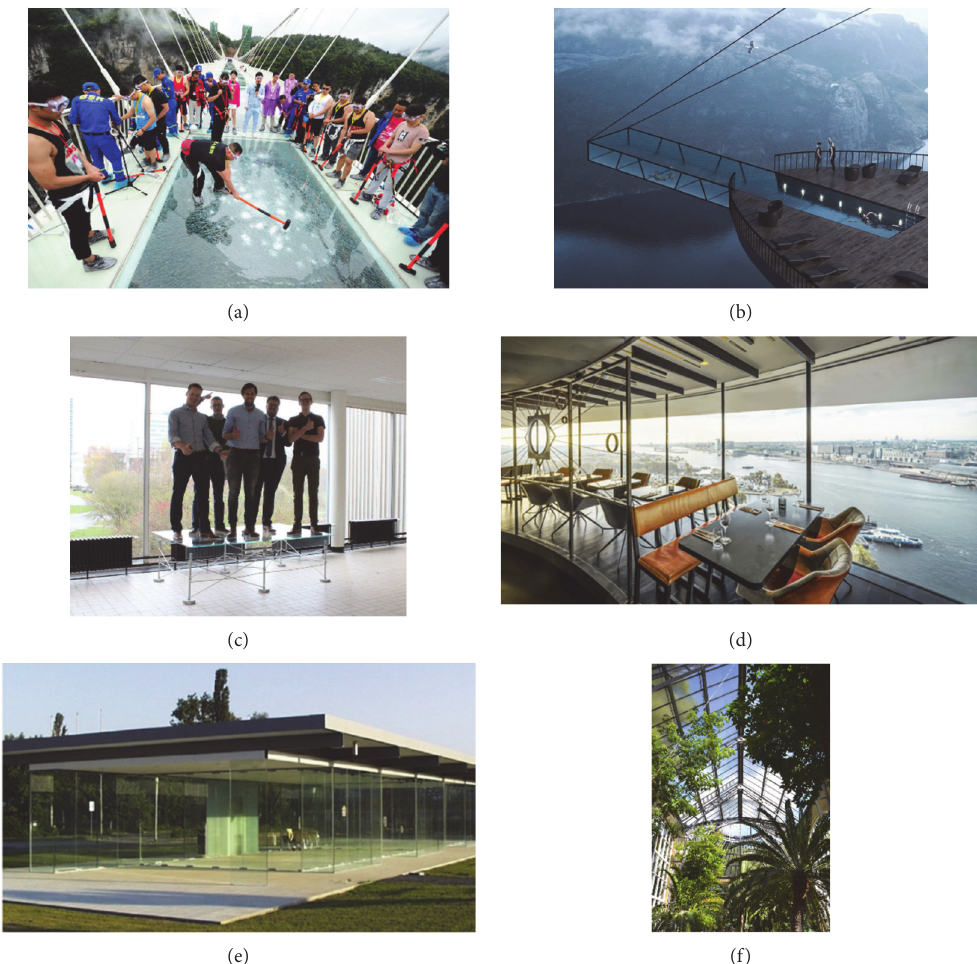
Figure 12: Static input items with prevailing (a)-(b) NEG, (c)-(d) POS reactions, or (e)-(f) balanced NEG-POS reactions: (a) Zhangjiajie bridge, Hunan, CN (© Getty Images); (b) cliff concept boutique hotel (© Hayri Atak); (c) mock-up of glass floor system (© Vitroplena bvba, BE); (d) walls (Amsterdam, NL (© A’DAM Lookout)); (e) walls (Glass Pavilion Rheinbach, DE (from [47] (© (F) Wellershoff)); (f) roof (Botanical Garden, Amsterdam, NL). (a) Item #25; (b) item #27; (c) item #10; (d) item #21; (e) item #3; (f) item